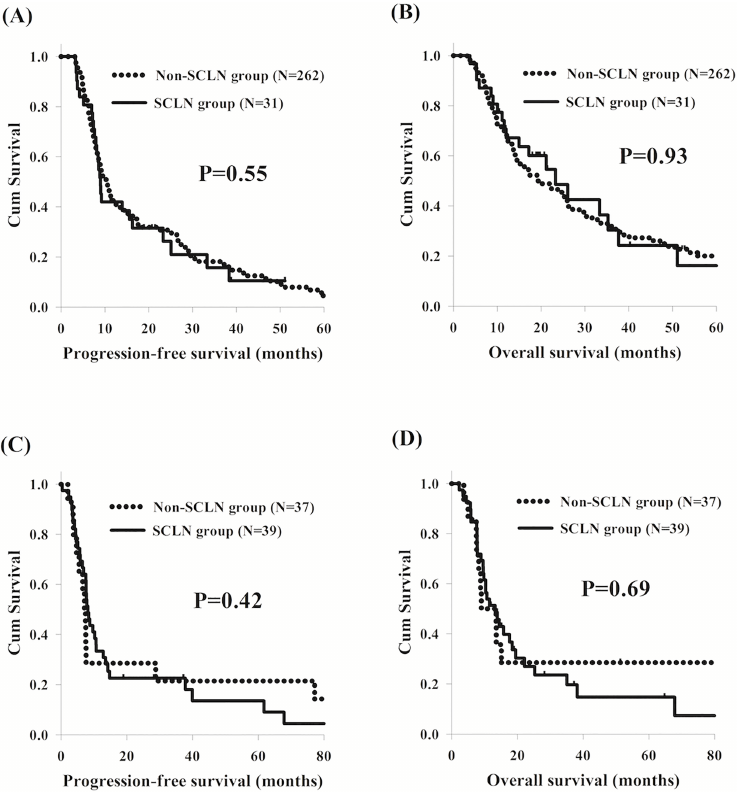
Fig 2. Comparison of survival curves of esophageal squamous cell carcinoma patients with or without SCLN metastasis in different N statuses. (A) N0-2 status, progression-free survival (B) N0-2 status, overall survival. (C) N3 status, progression-free survival (D) N3 status, overall survival. SCLN: supraclavicular lymph node.